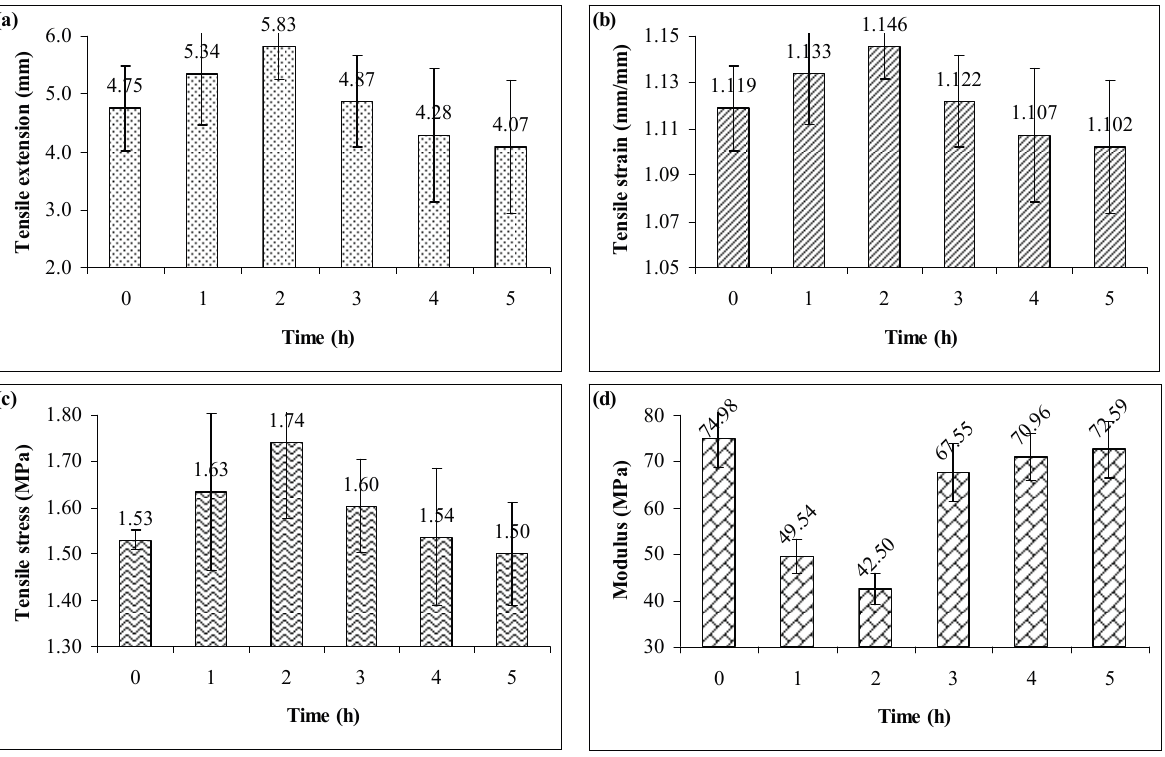
Figure 2. Influences of treatment time on ( a ) tensile extension; ( b ) tensile strain; ( c ) tensile stress; and ( d ) modulus at break of LDPE/CW